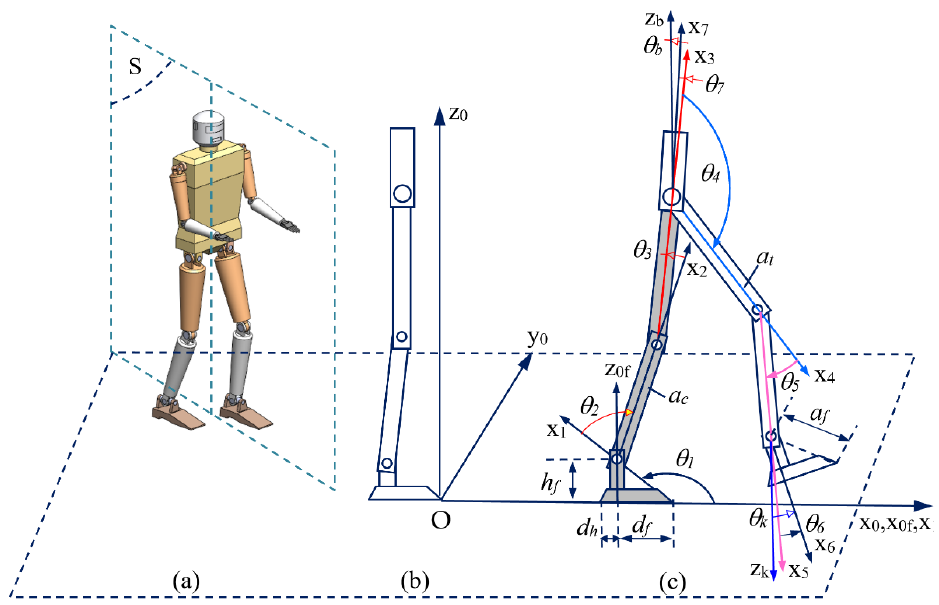
Figure 1. Bipedal robot model: ( a ) human-like bipedal robot; ( b , c ) robot ’ s kinematic scheme and coordinate systems.